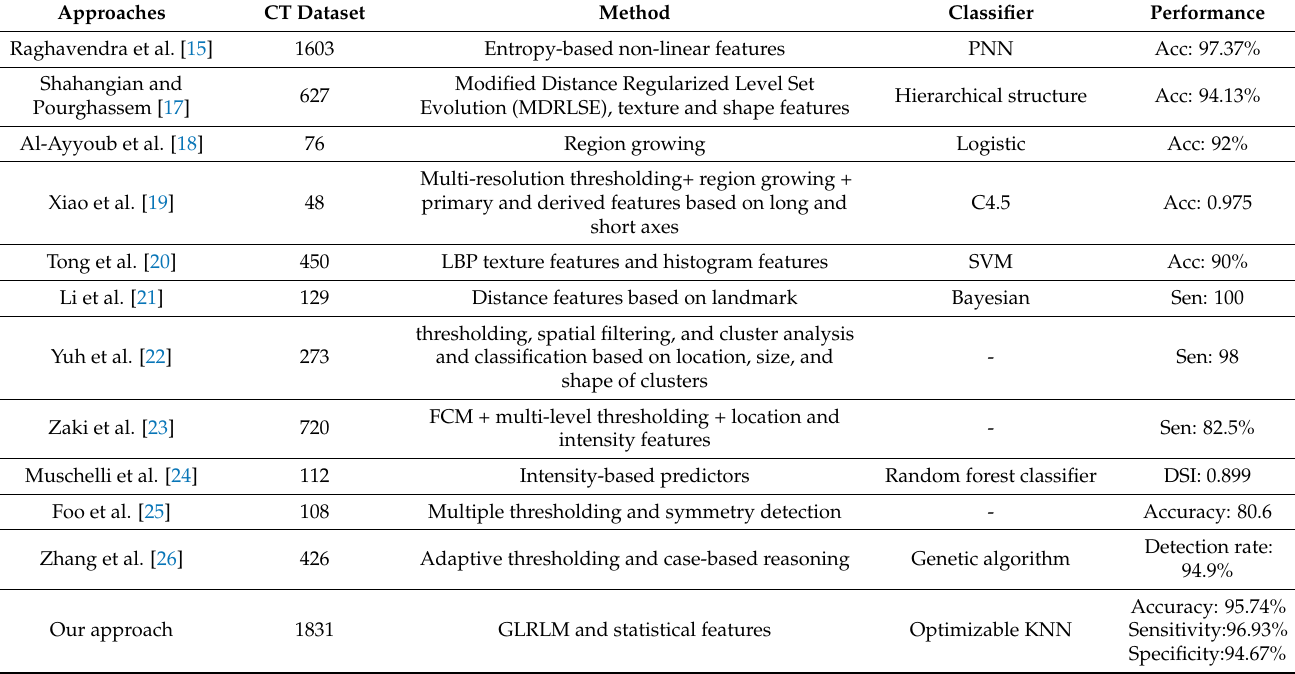
Table 11. Performance comparison of different techniques.